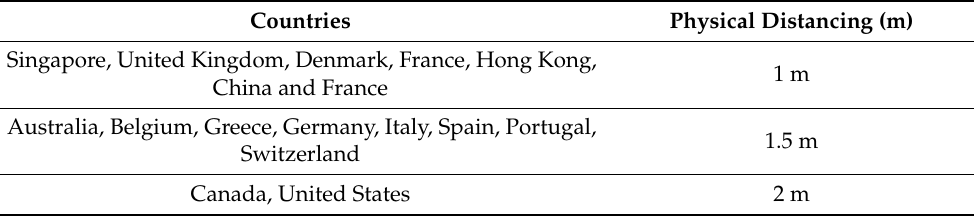
Table 3. Physical distancing campaigns among countries [46,47].